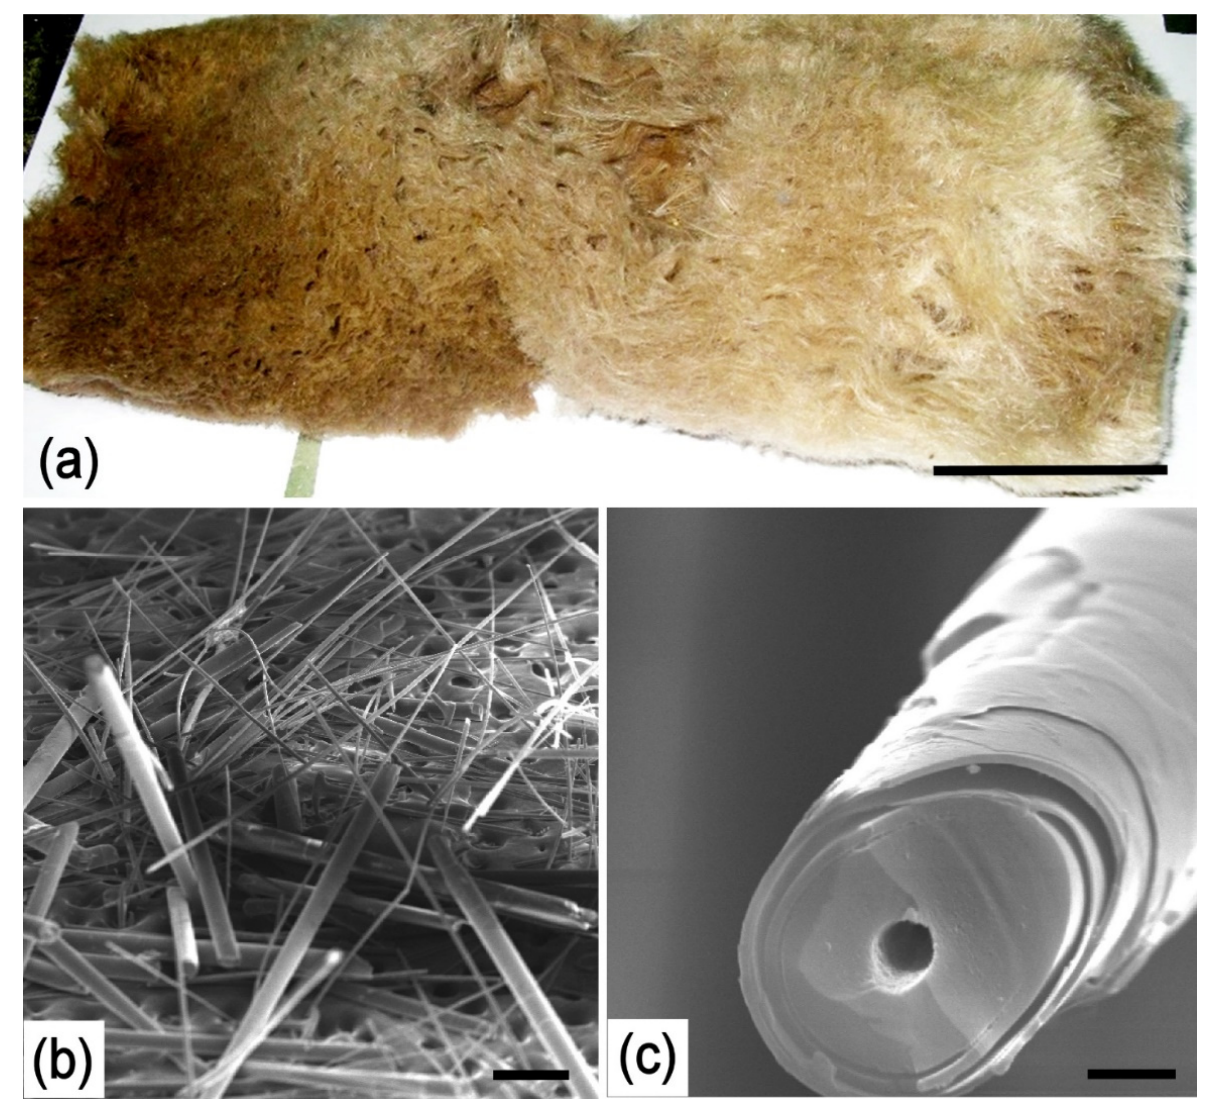
Figure 2. Schulzeviella gigasspinosum. Morphological feature ( a ) and the ultrastructure of the spicules by SEM ( b , c ). Scale: ( а )—10 cm, ( b )—400 μ , ( с )—4 μ .